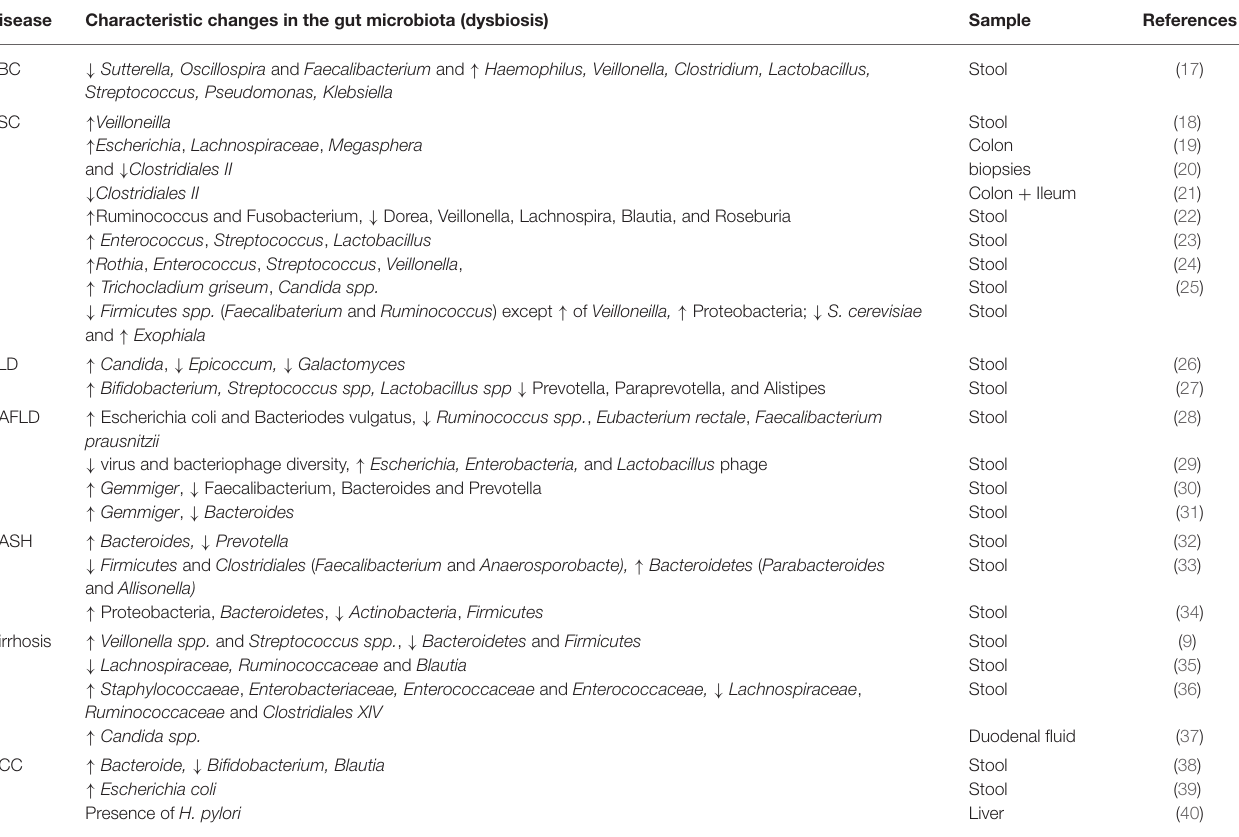
TABLE 1 | Summary of studies analyzing microbiota in chronic liver